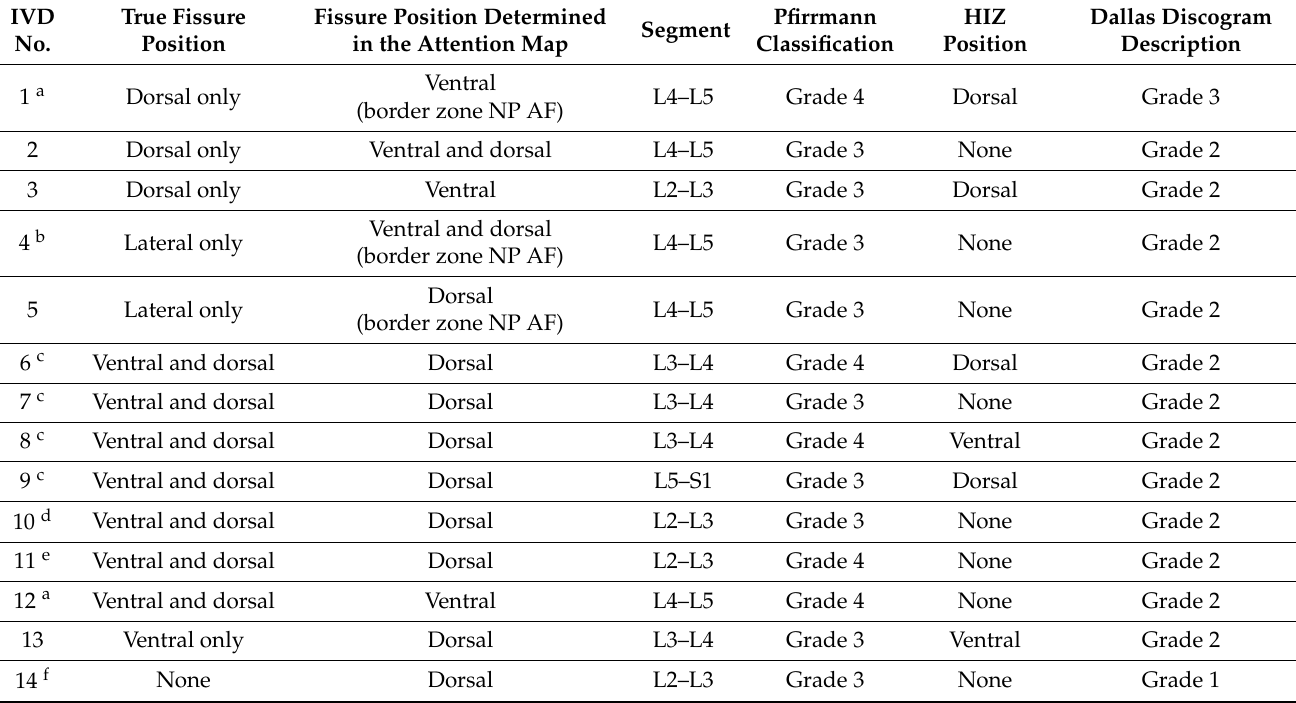
Table 4. Characteristics of IVDs where the corresponding attention maps failed to determine the true position of the annular fissures.